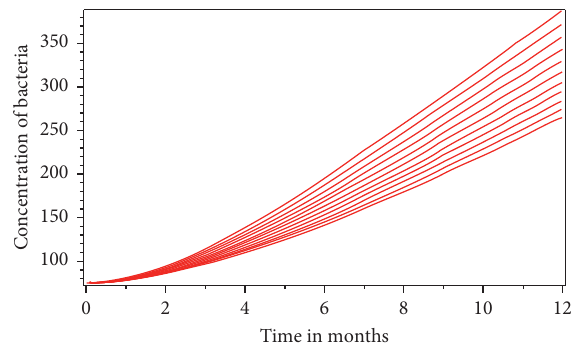
Figure 8: Approximate solution of concentration of bacteria for ϕ �